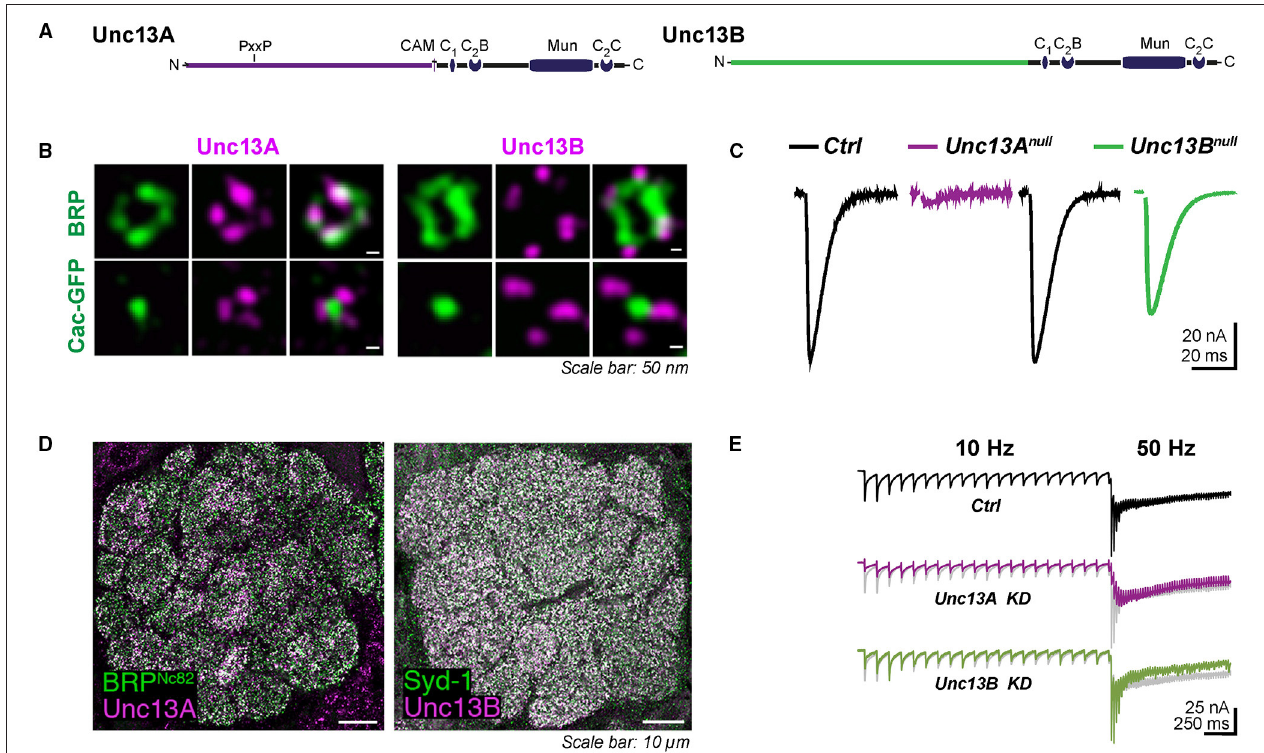
FIGURE 1 | (A) Domain structures of Unc13A and Unc13B. (B) Nano-topology of Unc13A and B at active zone (AZ) and their coupling distance to Ca 2 + channels at Drosophila neuromuscular junctions (NMJs) shown by super-resolution-stimulated emission depletion microscopy (STED) images. Synaptic transmission at NMJ is dominantly controlled by Unc13A. Null mutants of Unc13B only showed a mild reduction in the response evoked, recording traces shown in (C) . (D) Expression pattern of Unc13A and Unc13B in the antennal lobe of Drosophila. (E) Synaptic currents evoked recorded at fast-depressed olfactory receptor neuron (ORN)-to-projection neuron (PN) synapses. (A–C) are modified from Bohme et al. (2016) and (D,E) are modified from Fulterer et al.